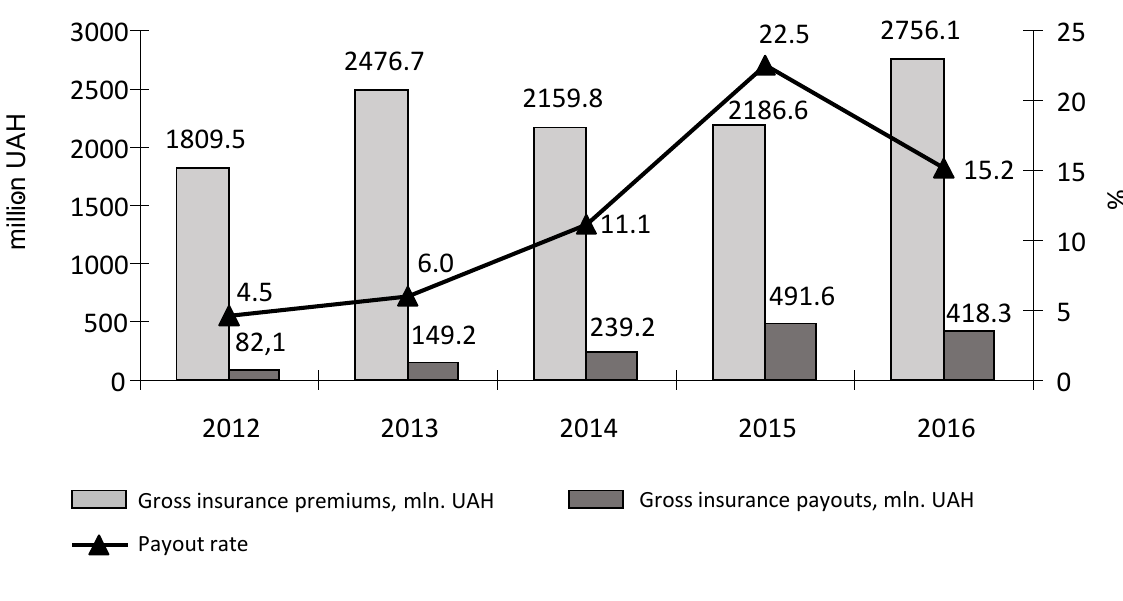
Figure 2. Payouts in life insurance in Ukraine for the period